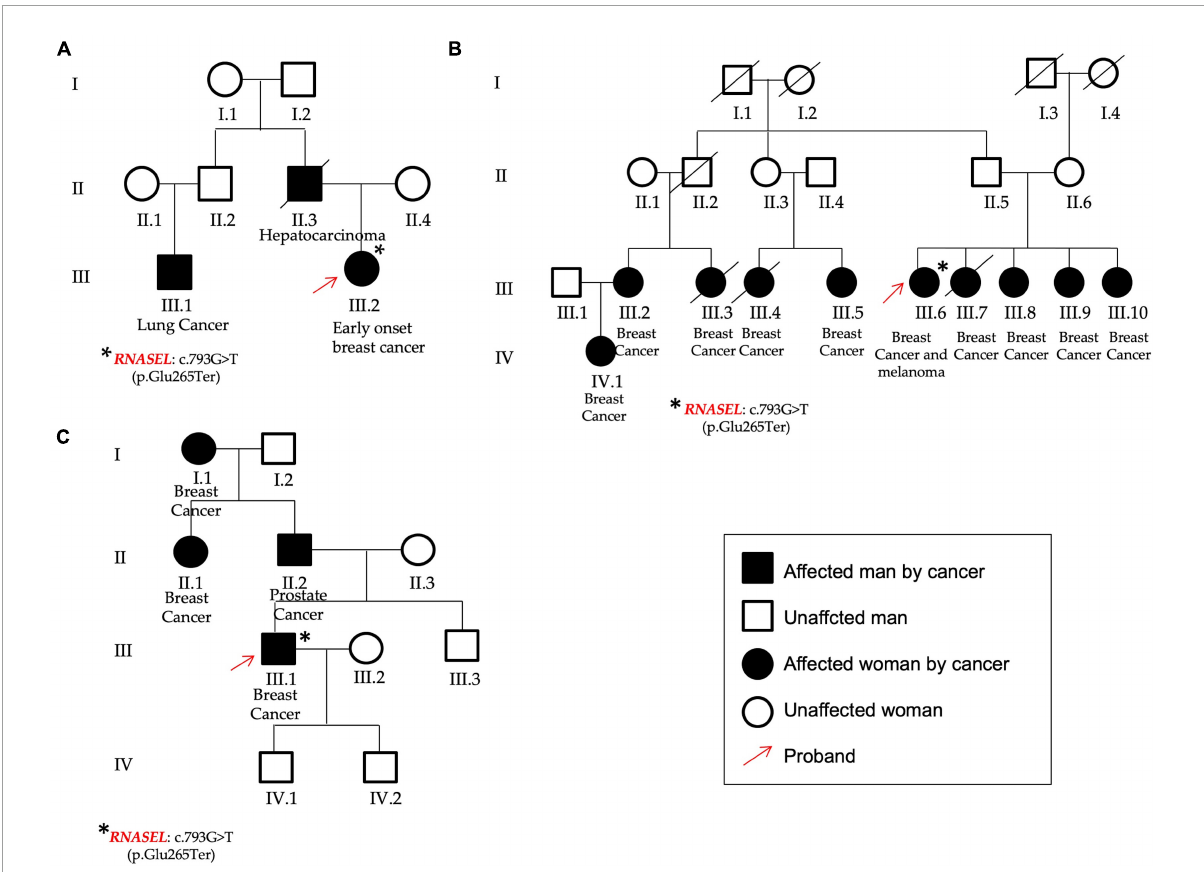
FIGURE4 Pedigrees of P13 (A) , P54 (B) , and P32 (C) patients found to carry the same variant in the RNASEL gene. (A) The patient was affected by early onset breast cancer and showed different cases of hepatocarcinoma and lung cancer; (B) The patient affected by breast cancer and melanoma showed other cases of breast cancer from both the paternal and the maternal branches. (C) The male patient was affected by breast cancer and declared other cases both for breast and prostate cancers. Red arrows identified the three probands, asterisks the RNASEL gene